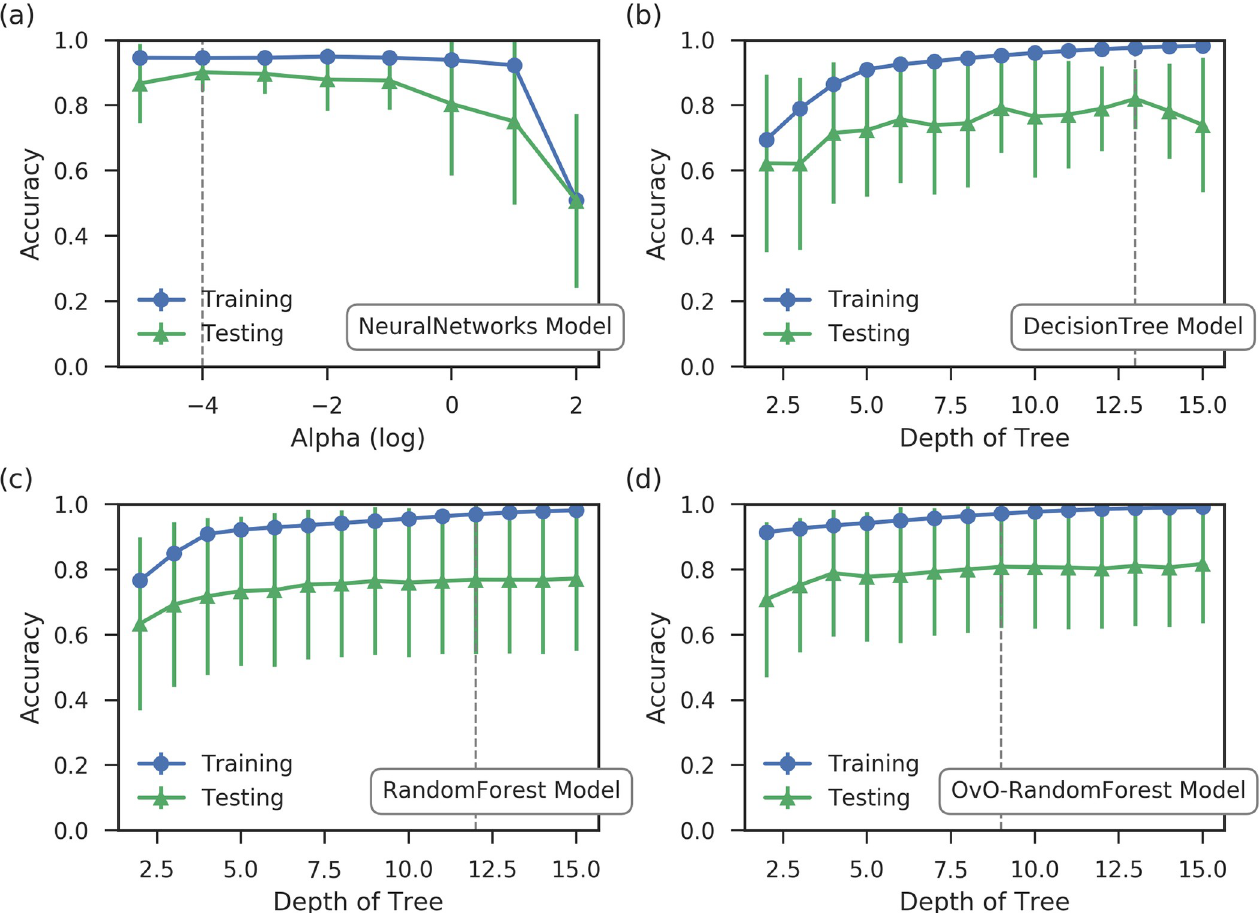
Fig 6. The training models for macrostates using different machine learning model: (a) Artificial neural networks, (b) decision tree, (c) random forest, and (d) one-vs-one random forest. All the training are based on 120,000 frames extracted from 12 μ s MD trajectories. In each frame, 10,878 C α pair-wise distances are used as features for model development. All models show high training and testing accuracy, validating the appropriation of machine learning models for VVD